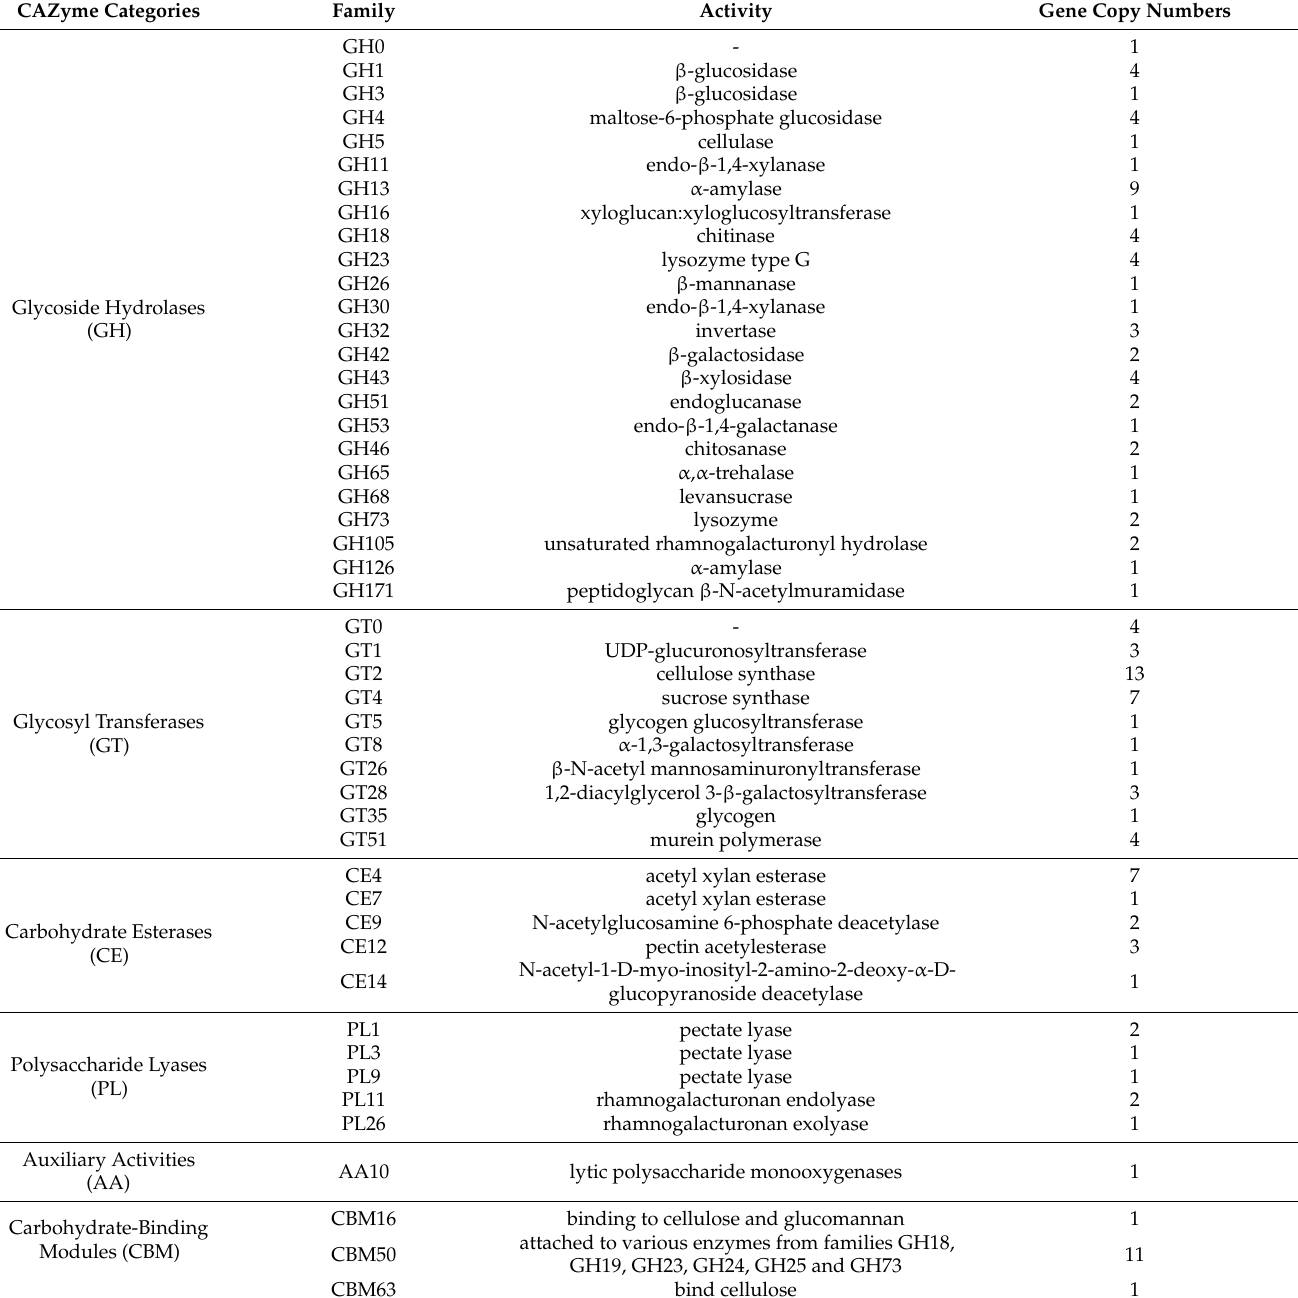
Table 2. Distribution of CAZymes gene families in the genome of B. halotolerans